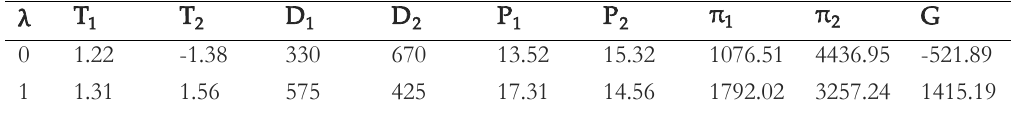
Table 2. Equilibrium values obtained for